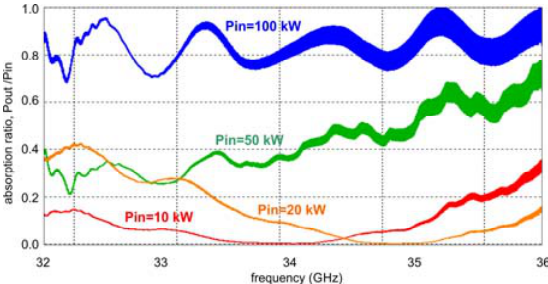
Fig. 2. Dependence of the absorption ratio of the cyclotron absorber on the frequency for various levels of incident power.